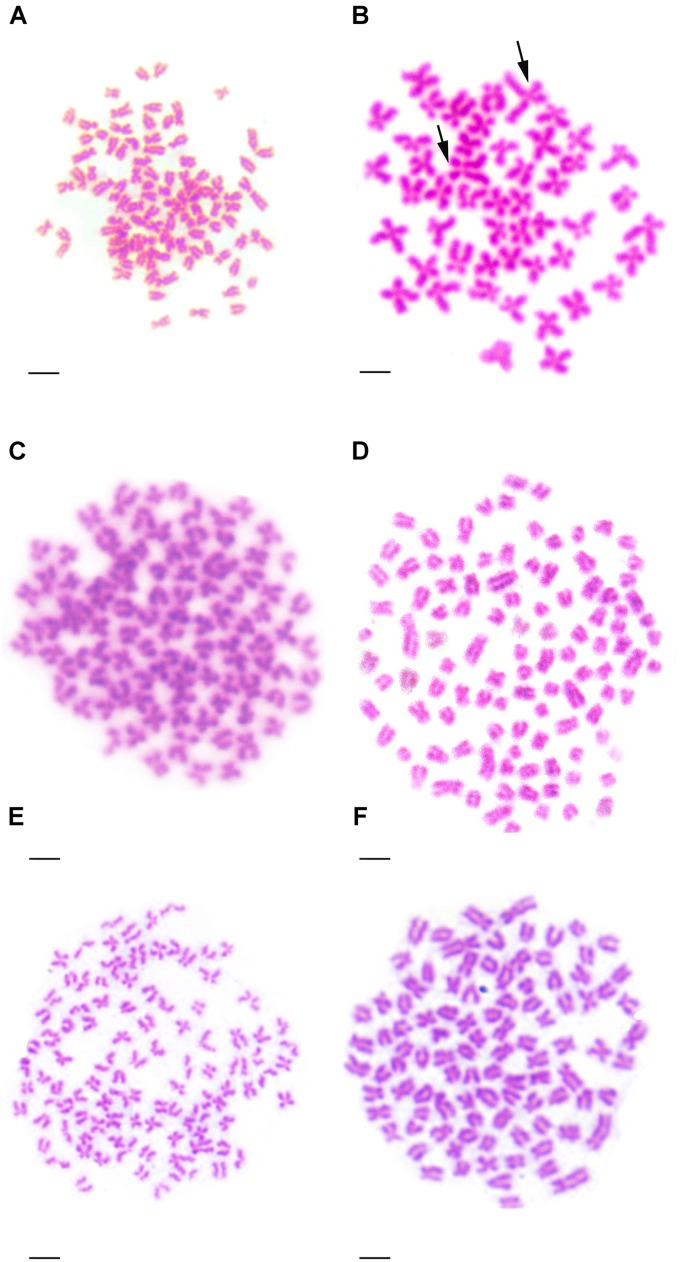
Chromosome spreads at metaphase in KOC, BSB, RCC-L, GF-L, GF, and RCC. (A) The 100 chromosomes of KOC. (B) The 48 chromosomes of BSB in which a pair of the largest submetacentric chromosomes (black arrows) is indicated. (C) The 100 chromosomes of RCC-L in which the largest submetacentric chromosome was not found. (D) The 100 chromosomes of GF-L in which the largest submetacentric chromosomes were not found. (E) The 100 chromosomes of GF in which the largest submetacentric chromosomes were not found. (F) The 100 chromosomes of RCC in which the largest submetacentric chromosomes was not found. Bar = 3 μm.